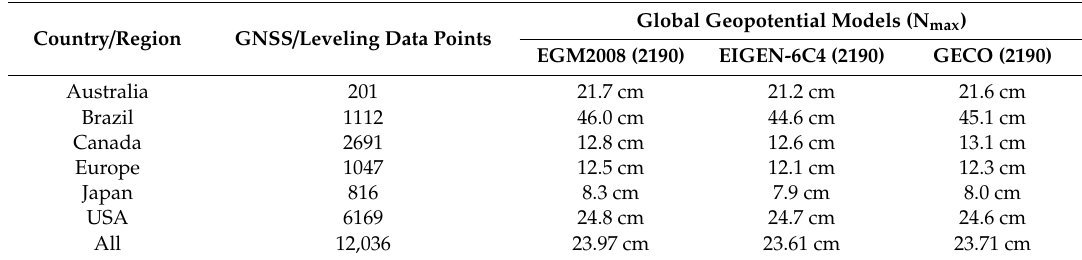
Table 1. Precision levels of the GGMs used in this study [19].